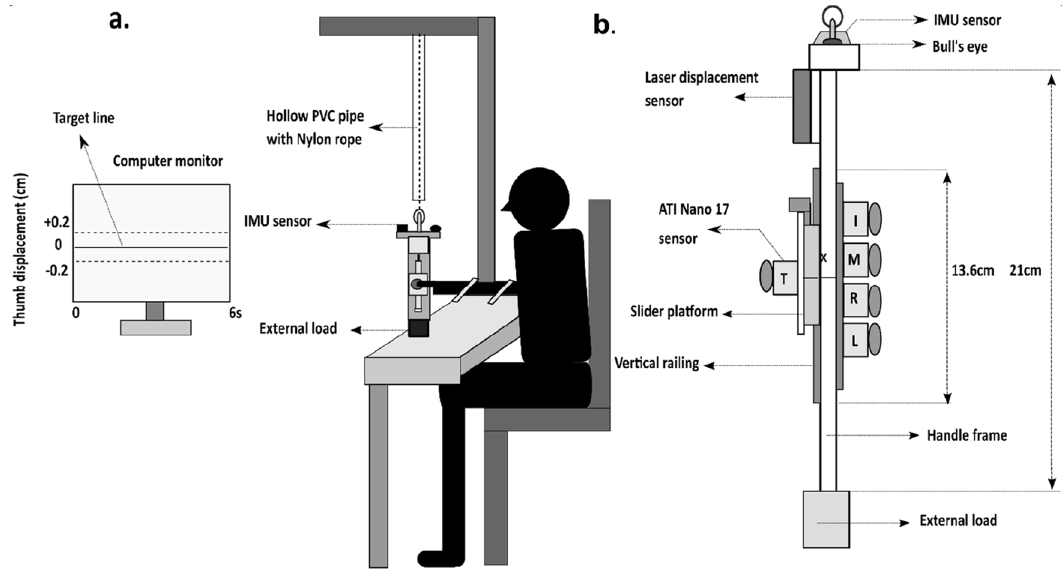
Figure 1. Schematic diagram of the experimental setup and five-finger prehensile handle. ( a ) Experimental setup with the participant holding the handle at a distance of 1.5 m away from the computer monitor. The handle was suspended from a wooden support using a nylon rope housed within the hollow PVC pipe to restrict the lateral movements of the handle. The solid horizontal target line was shown on the computer monitor with two dashed lines that represented an acceptable error margin. ( b ) Schematic diagram of the experimental handle. The aluminium handle frame (21 × 1 × 3) cm with five fingertip force (ATI Nano 17) sensors, laser displacement sensor, and orientation measuring sensor (IMU) are shown. The grip aperture of the handle is 6.2 cm. External loads of 0.150, 0.250, 0.350, and 0.450 kg were attached at the bottom of the handle (i.e.) below the center of mass (represented as ‘X’) of the handle. I, M, R, L, T represents Index, Middle, Ring, Little, and